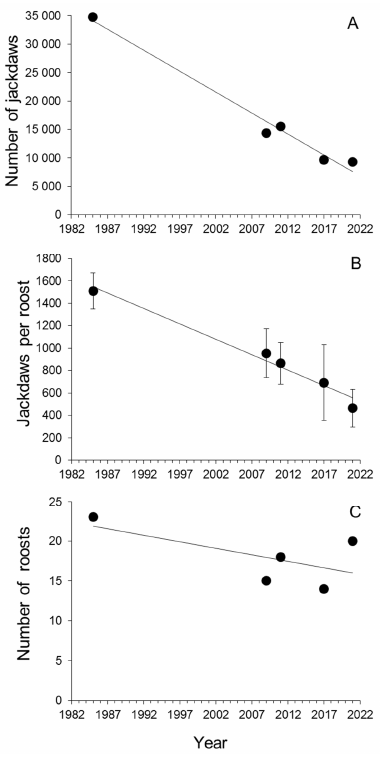
Figure 7. Relationships between year and ( A ) number of jackdaws in winter communal roosts, ( B ) mean ± SE roost size, and ( C ) number of communal roosts in the study area in Central Spain (see Figure 6 for details). Least squares regression lines of the correlations are shown for graphical representation of trends.